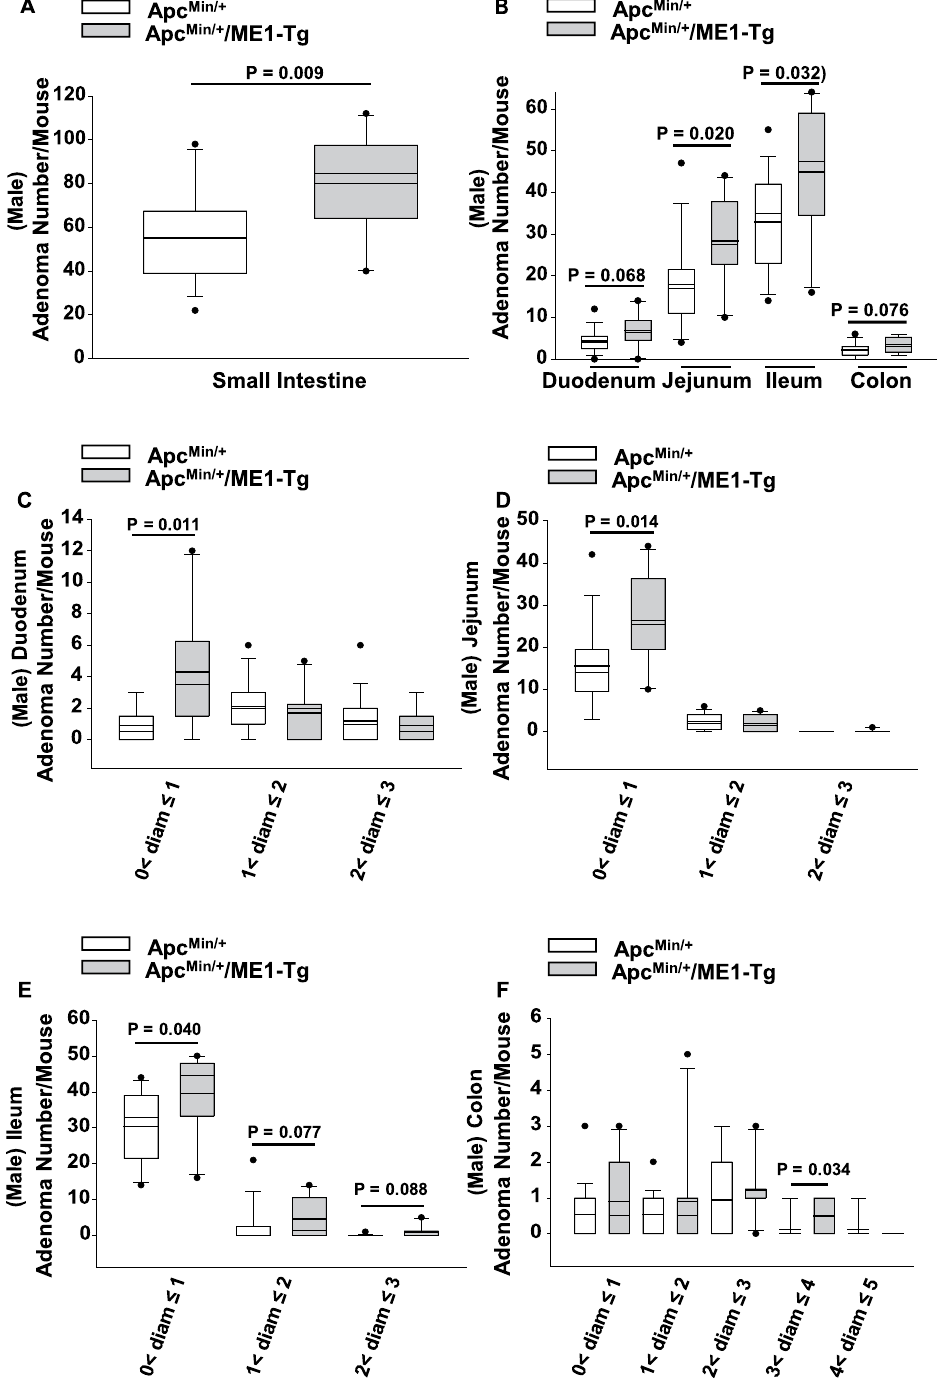
Figure 2. Adenoma burden in male Apc Min/ + /ME1-Tg mice. ( A ) Total number of adenomas/mouse in the small intestines of sixteen-week-old Apc Min/ + (n = 17) and Apc Min/ + /ME1-Tg (n = 10) male mice. ( B ) Regional distribution of adenomas in male mice. ( C–F ) Size distribution of adenomas in the ( C ) duodenum, ( D ) jejunum, ( E ) ileum and ( F ) colon of sixteen-week-old male Apc Min/ + and Apc Min/ + /ME1-Tg mice. Boxes indicate the inter-quartile range (25–75%) with mean (thick line) and median (thin line); whiskers: 10 th and 90 th percentiles; dots: outliers. Student’s t -tests were used to examine for differences between groups and the Mann- Whitney Rank Sum Test was used for comparing non-normally distributed data. Significant differences were identified by P < 0.05. Tendencies for differences also are indicated (0.1 > P >